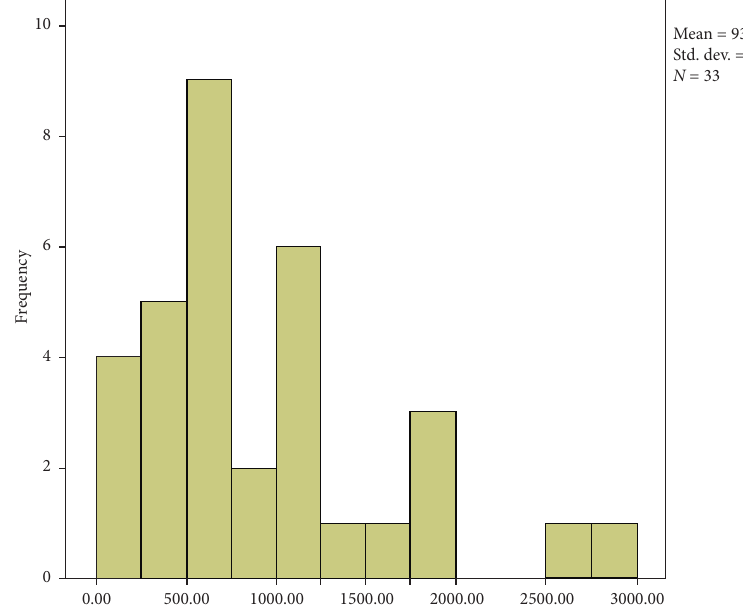
Figure 1: Daily maximum current (histogram).